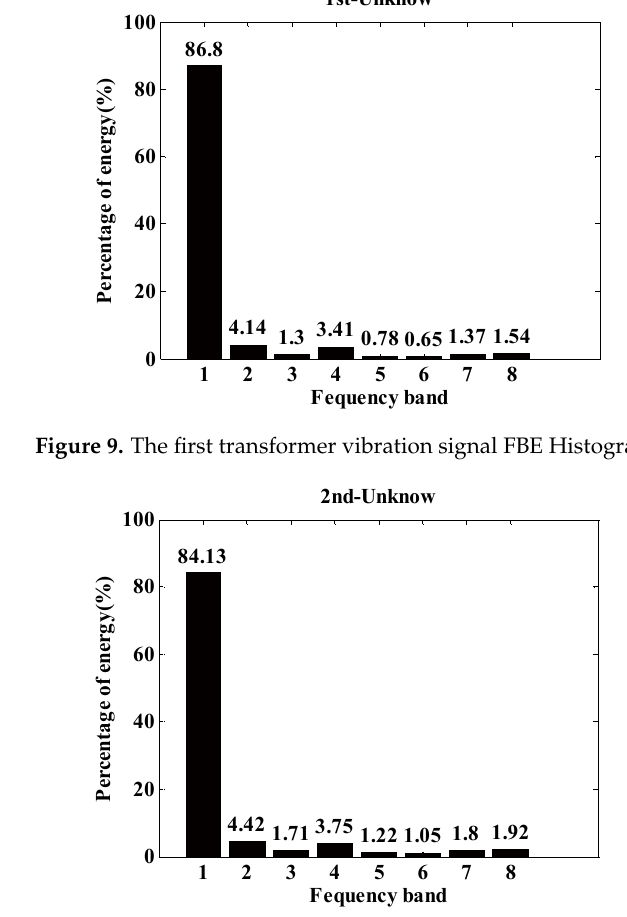
Figure 10. The second transformer vibration signal FBE Histogram.